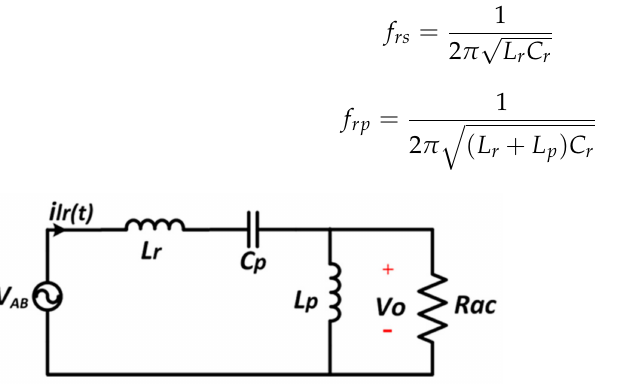
Figure 27. Equivalent circuit of the DC-DC series-parallel resonant converter